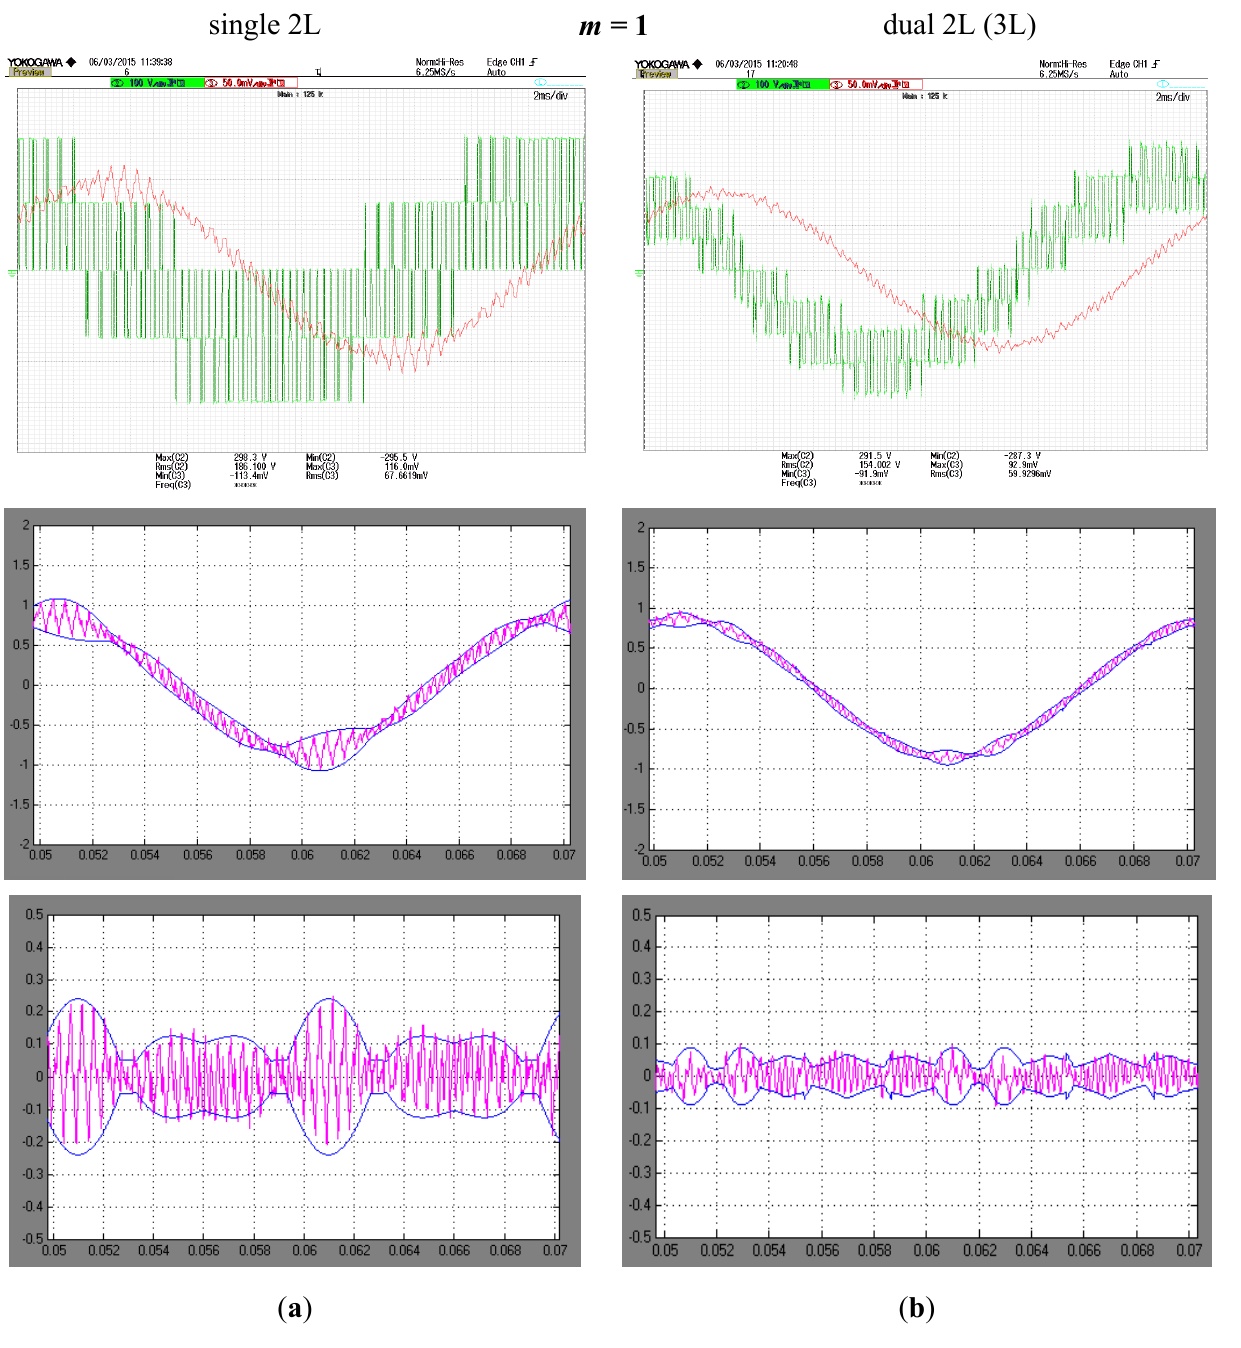
Figure 9. Experimental results: details of the output voltage and current waveforms from the oscilloscope, instantaneous output current with calculated peak-to-peak amplitude envelopes, and detail of current ripple with envelopes for m = 1: ( a ) single-2L inverter; ( b ) dual-2L (3L)